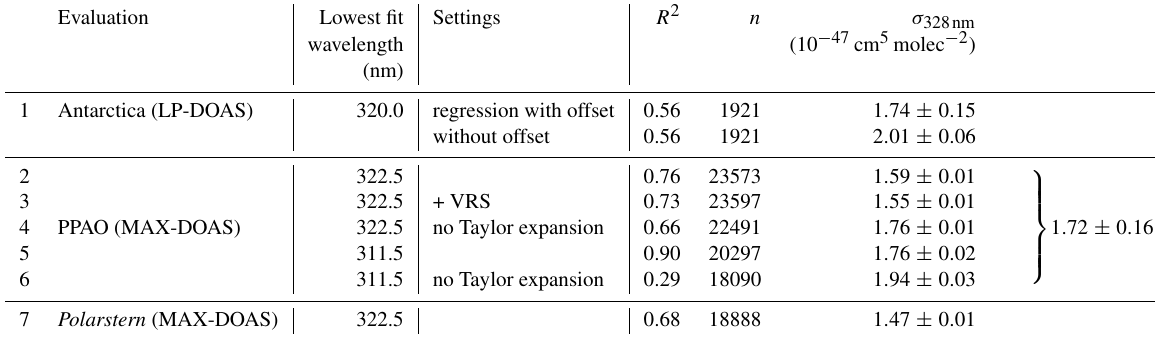
Figure 2. Exemplary LP-DOAS fit result of a measurement from 22 November 2012 on the 8km light path. The O 4 absorption at 328nm is clearly visible. The retrieved column densities are O 4 ( 2 . 67 0 . 04 ) 10 43 molec 2 cm − 5 and O 4 328nm ( 6 . 09 0 . 38 ) 10 42 molec 2 cm − 5 . ± × ± × Table 3. Results for the O 4 absorption at 328nm for different fit ranges and settings. MAX-DOAS data were selected according to RMS < 4 10 − 4 and LP-DOAS data below an RMS of 1 . 2 10 − 4 , which then results in a different value for n , the number of valid observations. × × The correlation coefficient R 2 was calculated in each case. The peak magnitude of the absorption cross section at 328nm was calculated using the O 4 cross section published by Thalman and Volkamer (2013) using the maximum cross-section value of 9 . 5 10 − 47 cm 5 molec − 2 × at 343.8nm. The wavelength dependence of the O 4 AMF for the MAX-DOAS observations was not corrected here.